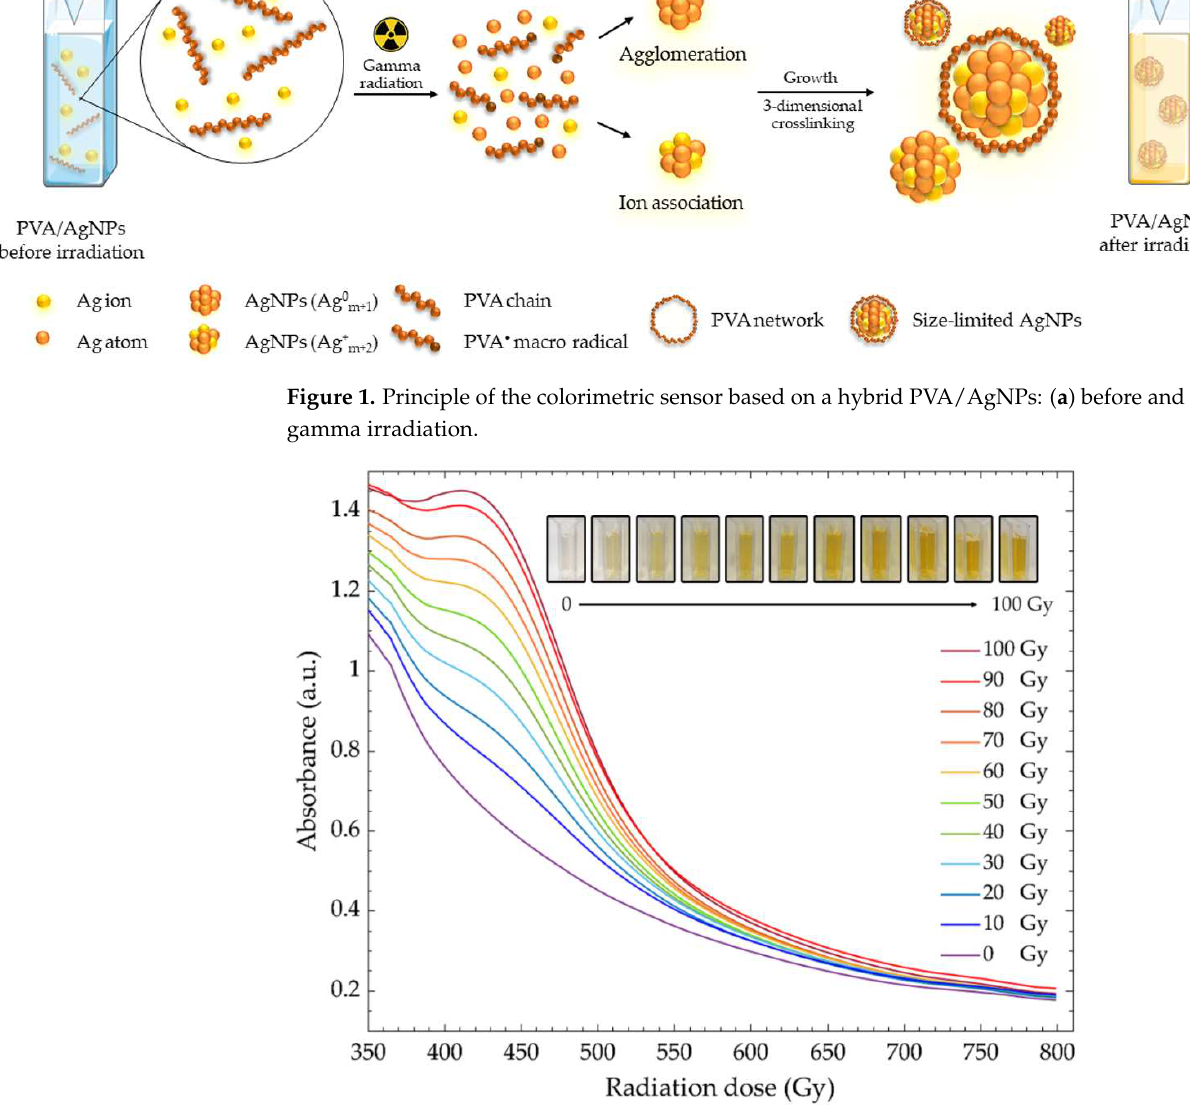
Figure 2. Absorption spectra and digital photographs of PVA/AgNPs solution before and after irradiation with gamma rays up to 100 Gy.